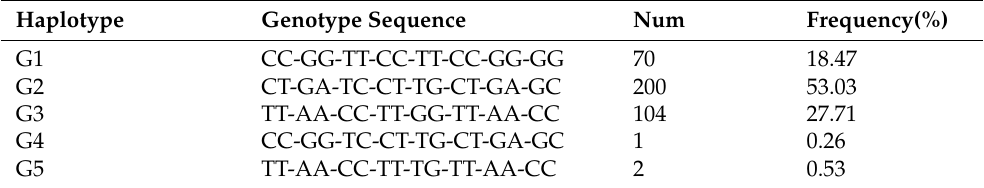
Figure 2. Linkage disequilibrium and haplotype block analysis using the seven SNPs for GPX2 and ALGA0043483 in 377 Duroc pigs. Solid lines mark the block identified. Linkage disequilibrium between each SNP is shown by the diamonds. Table 3. Genotype frequencies of ALGA0043483 and the seven SNPs in 377 Duroc